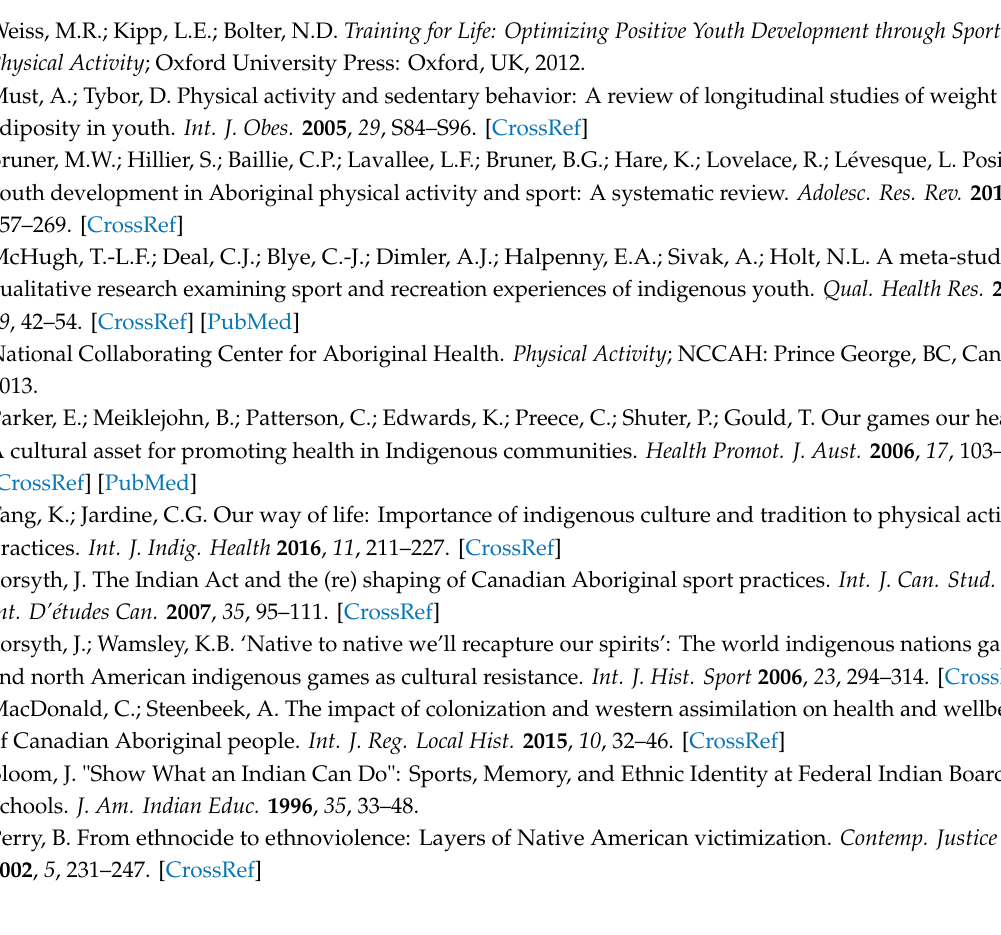
Table S1: Search strategy for four databases (Pubmed, Web of Science, ERIC, and Scopus) included in systematic review for traditional physical activity of Indigenous youth; Table S2: Critical appraisal criteria for systematic review on traditional physical activity of Indigenous youth adapted from the Joanna Briggs Institute [38]; Table S3: Details on the framework of included studies, as well as analysis techniques and degree of community involvement for systematic review on traditional physical activity of Indigenous